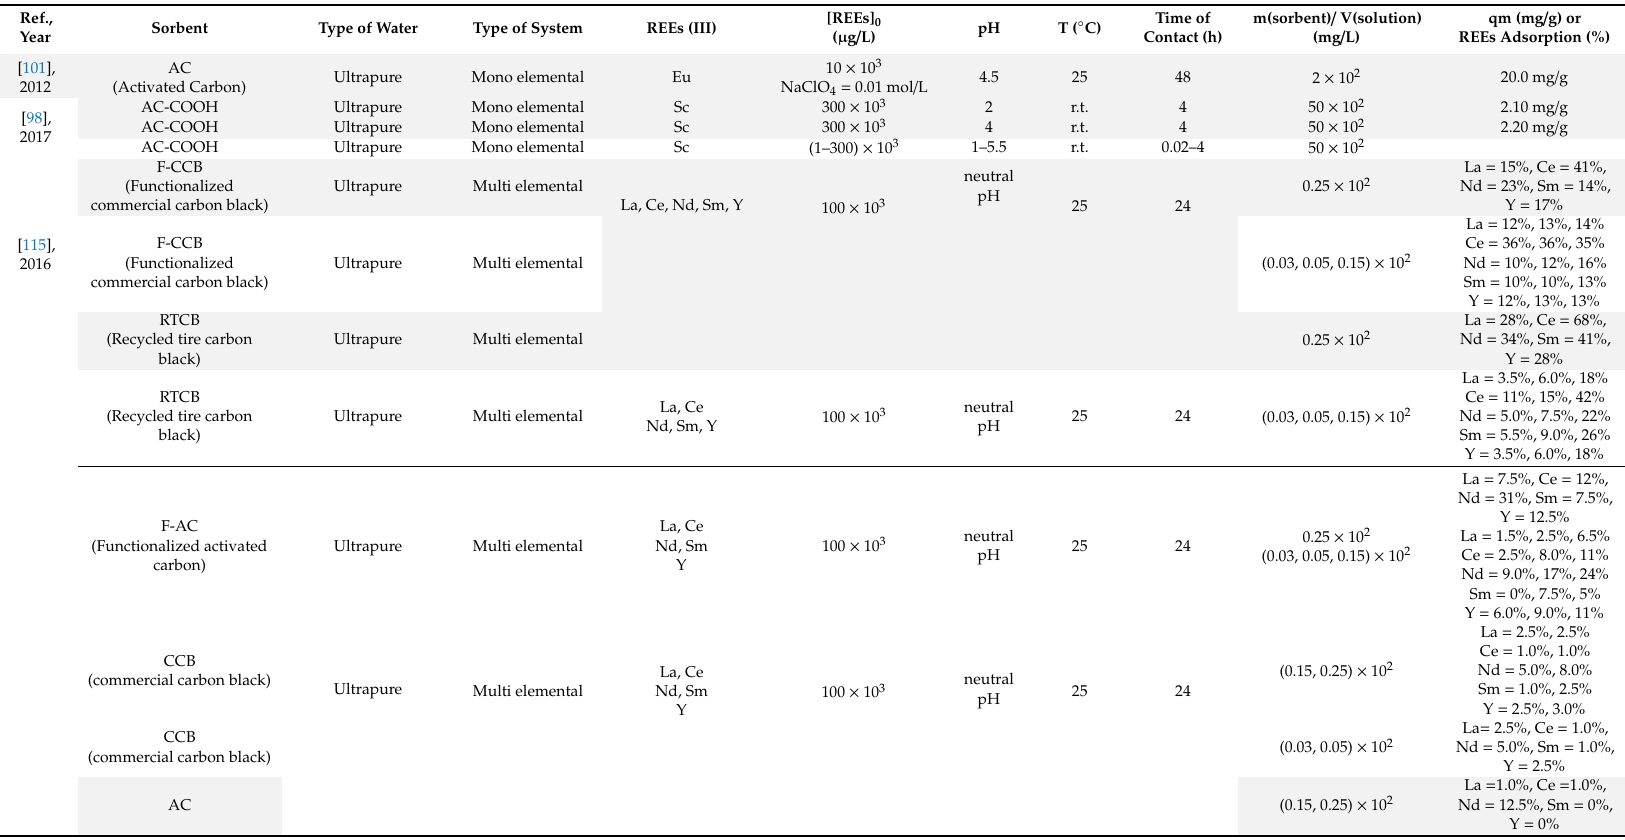
Table7. RecoveryofREEsusingothercarbonmaterials(ActivatedCarbon, Fullerene, C-Dots, CarbonBlack, MesoporousCarbon, Carbonnanofibers)andtherespectively experimental conditions used as reported in the